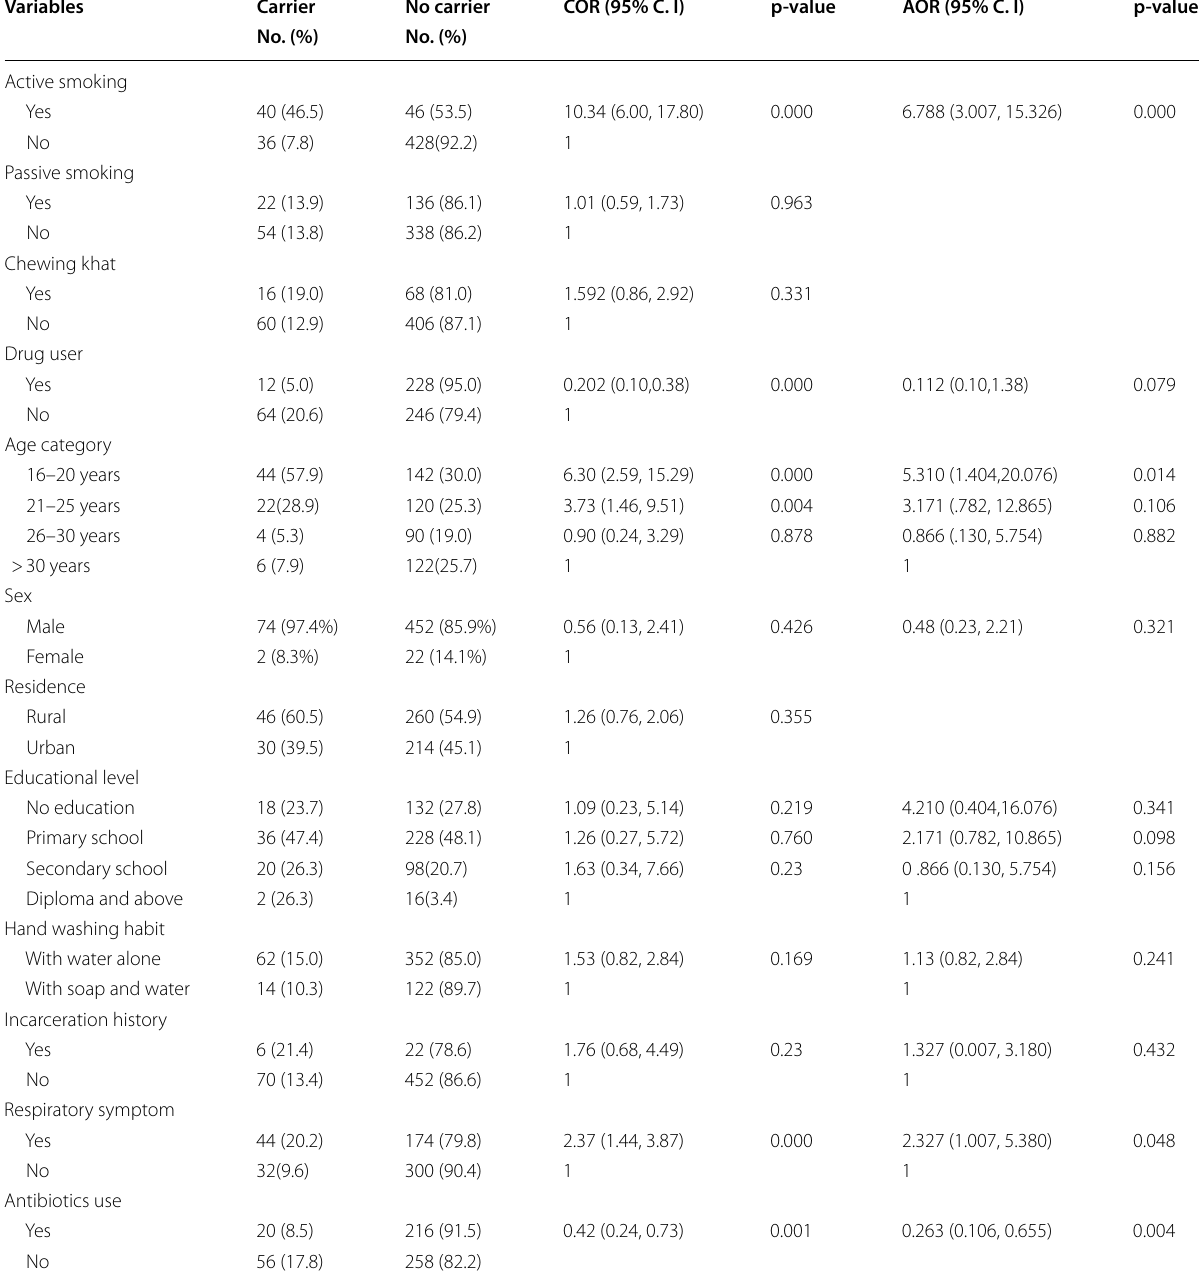
AOR adjusted odds ratio, COR crude odds ratio, CI confidence interval